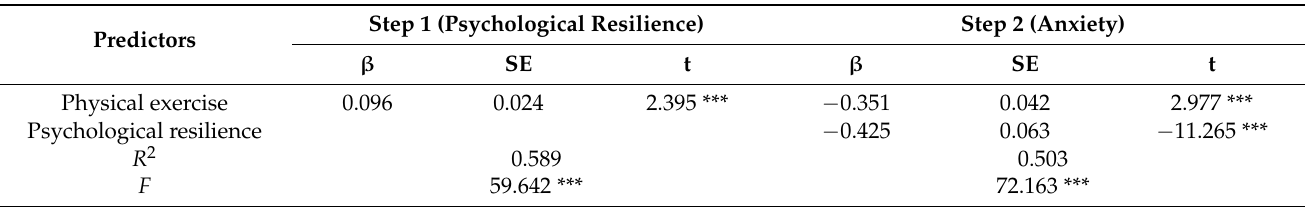
Table 5. Regression analysis of the mediation model.